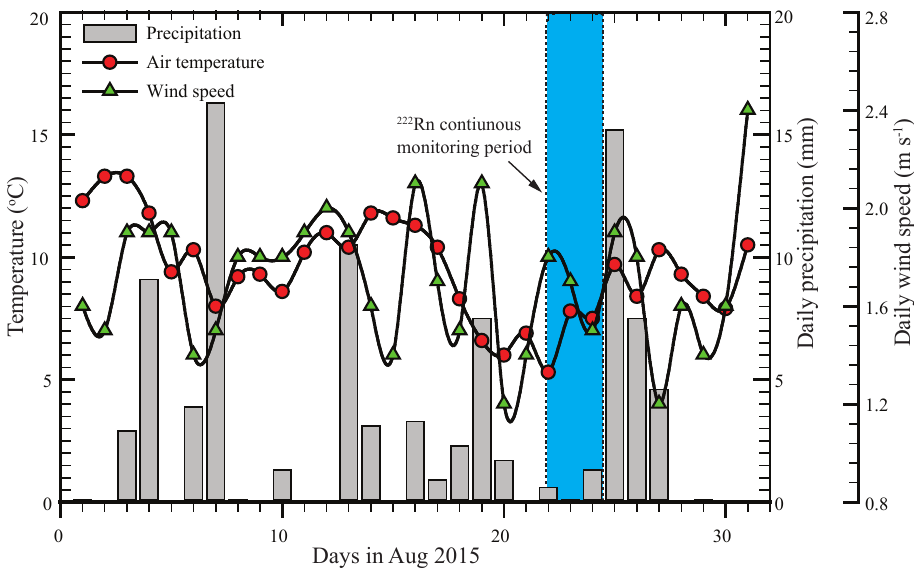
Figure 2. The climatological parameters (wind speed, air temperature, and precipitation) in August 2015 recorded from Jiuzhi weather